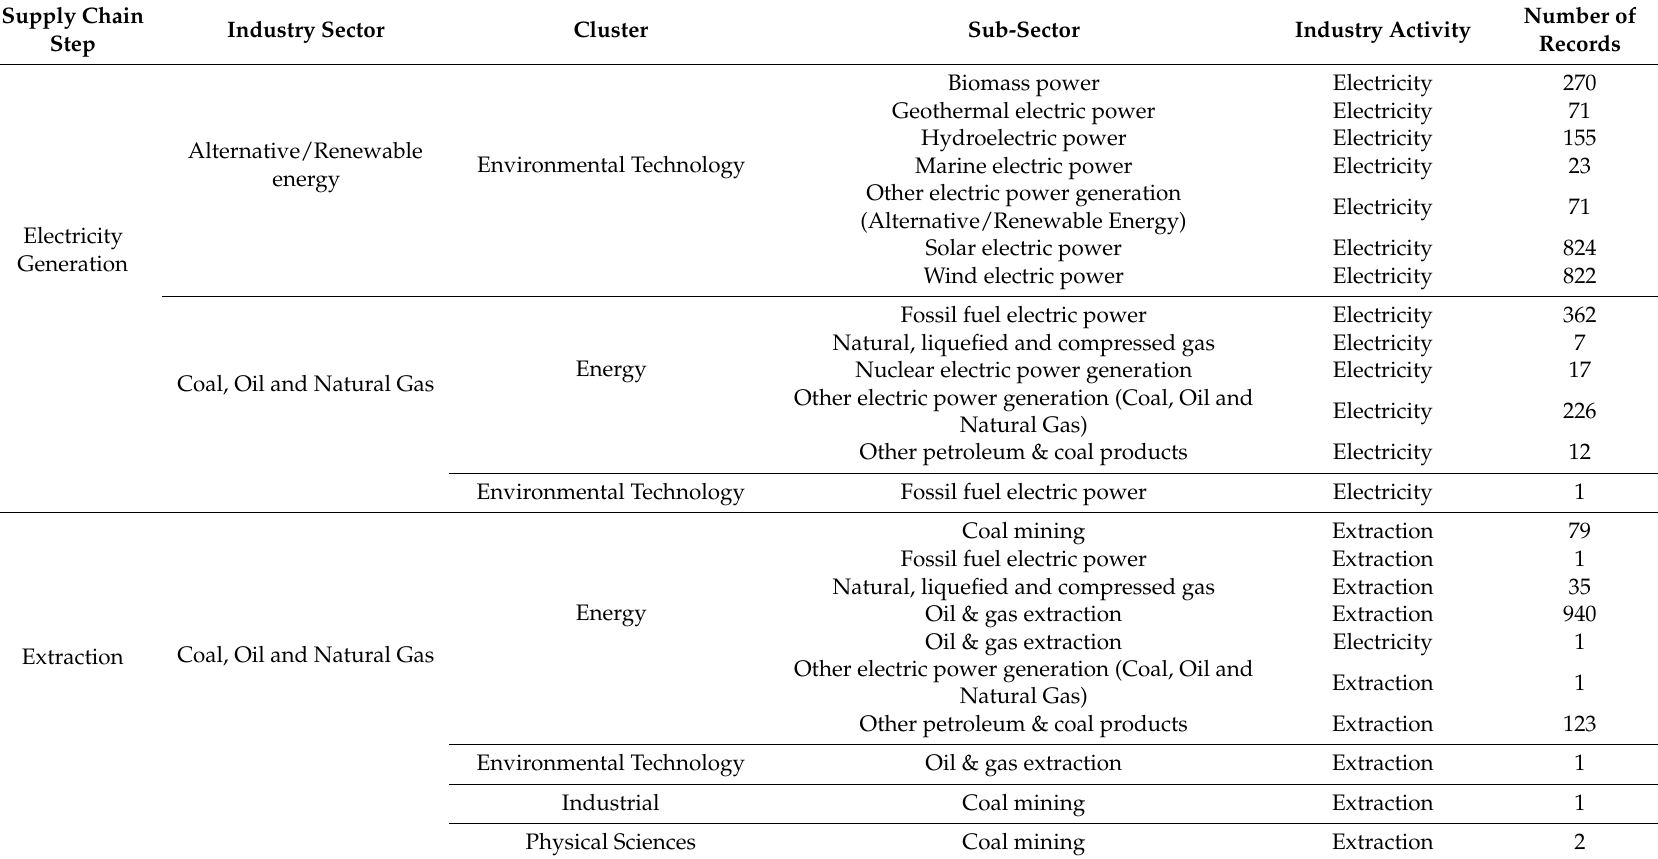
Table A2. Definitions for FDI Database: FDI Markets; Electricity Generation, Extraction,